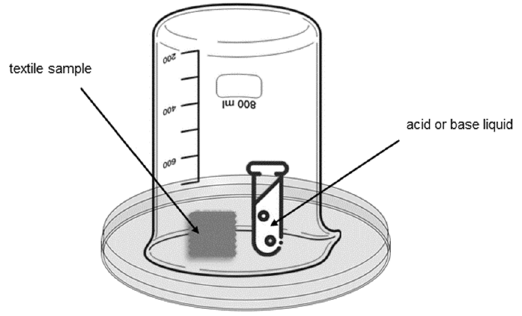
Figure 2. Set-up used in the sensitivity assay of textile samples to gases.